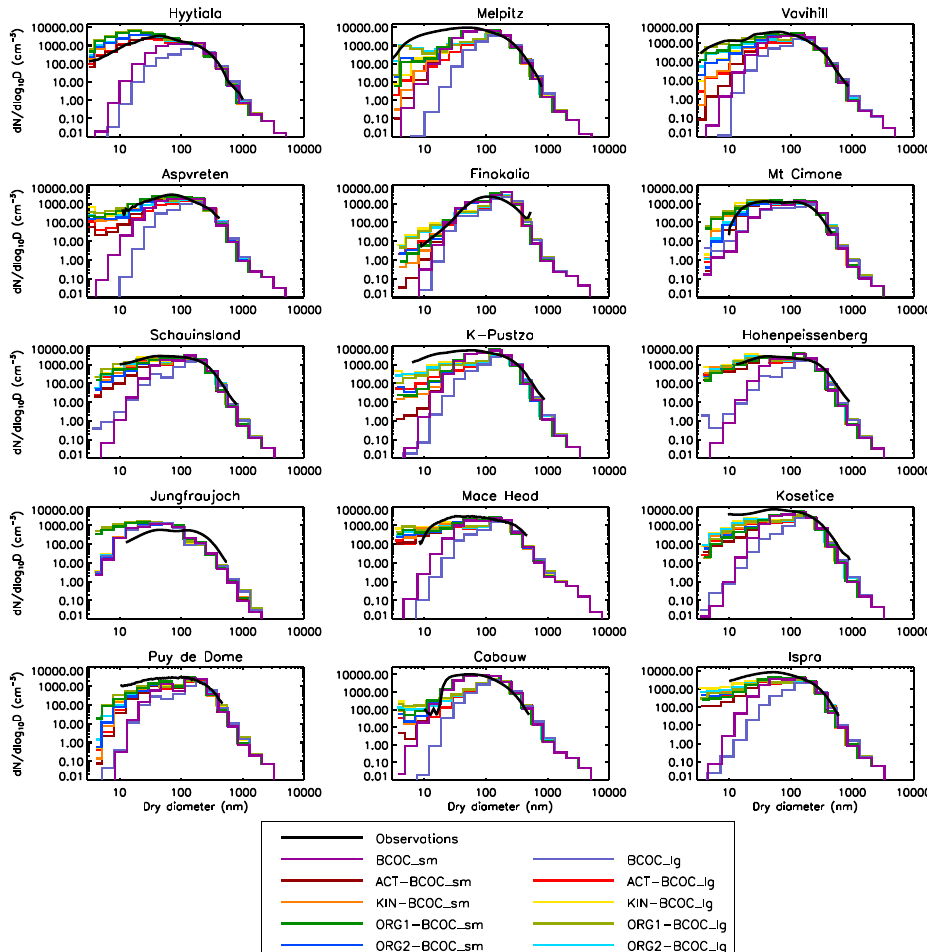
Fig. 4. Campaign-mean simulated (colour) and observed (black) total number size distributions at each ground site. Model experiments listed in the legend are described in Table